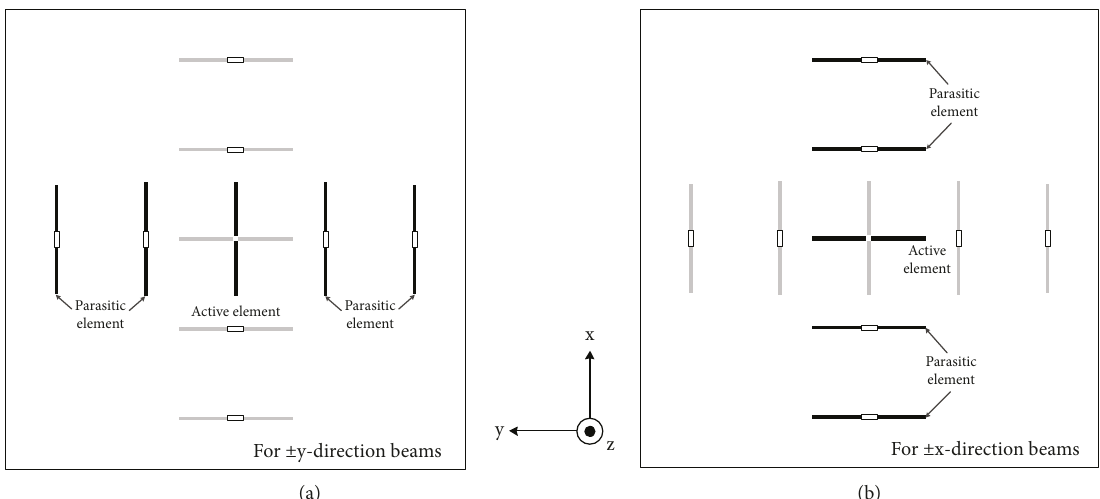
Figure 1: Orthogonal feeding process of the proposed planar beam steerable antenna.